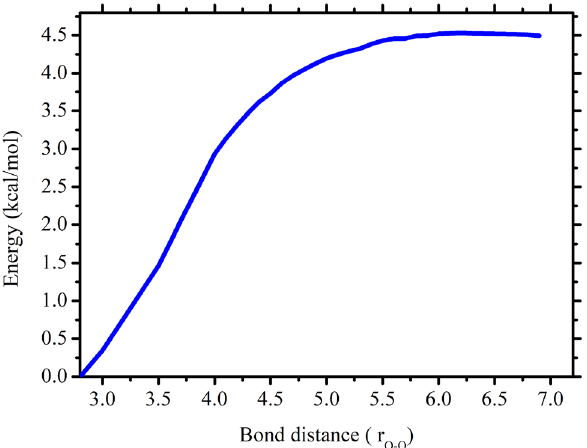
Figure 7. Zero-point corrected potential energy profile dissociation of the CH 3 OH···HO as functions of R O–O distances computed at the CCSD(T)/6-311++G (3df,3pd)//ωB97XD/6-311++G(3df,3pd) level.